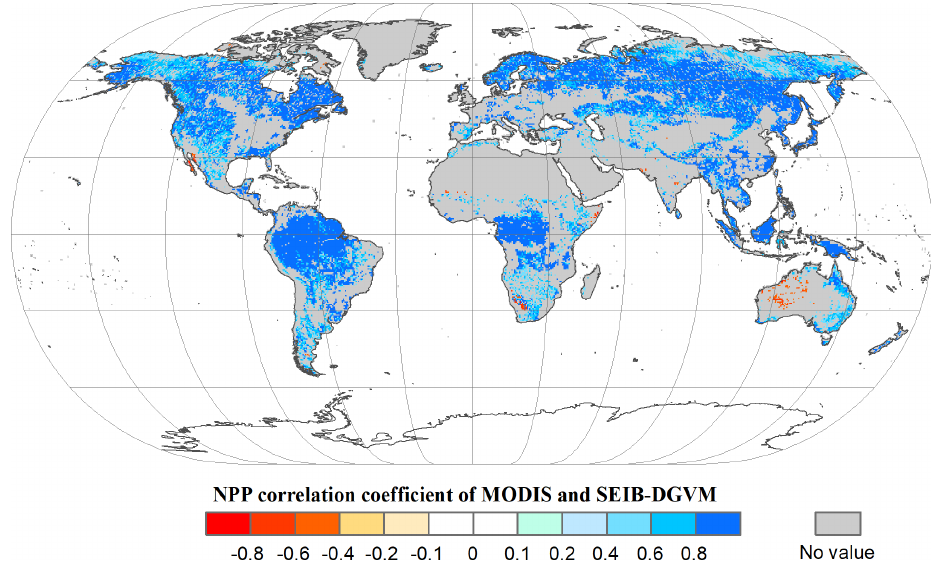
Figure 4. Spatial patterns in the potential NPP correlation coefficients ( P < 0.05) between SEIB-DGVM and MODIS between 2001–2015. These data were used to validate SEIB-DGVM.